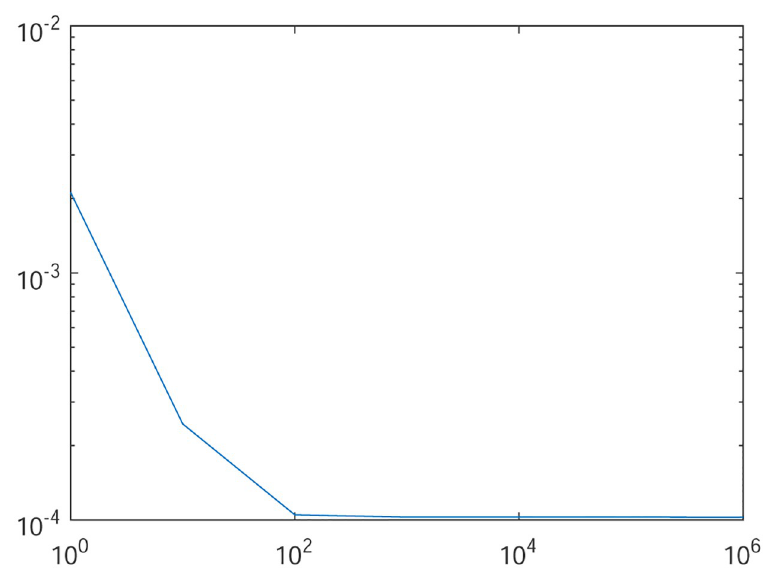
Fig 4. The behavior of the error with respect to the parameter θ for the Experiment 4.